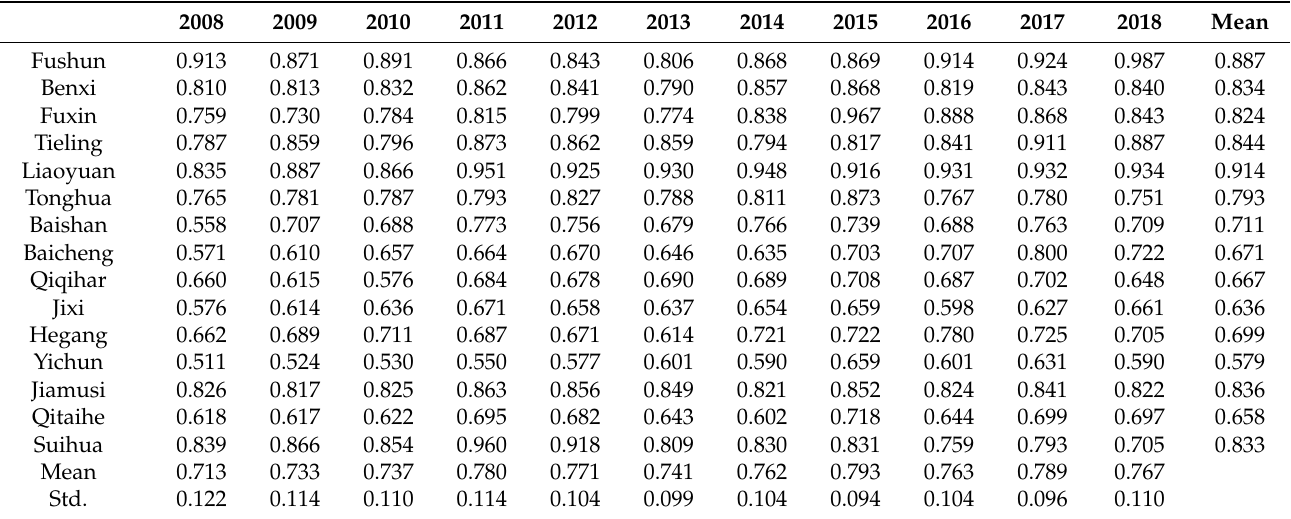
Table 5. The coupling coordination degree of shrinking city compactness and land-use efficiency from 2008 to